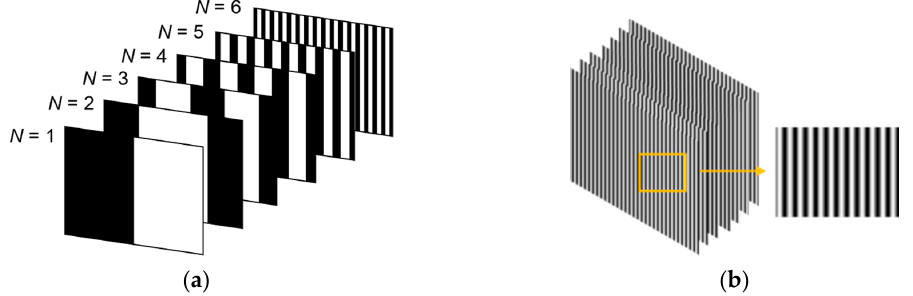
Figure 2. Structured light grating; ( a ) the gray code fringe pattern; and ( b ) the phase-shifting pattern.